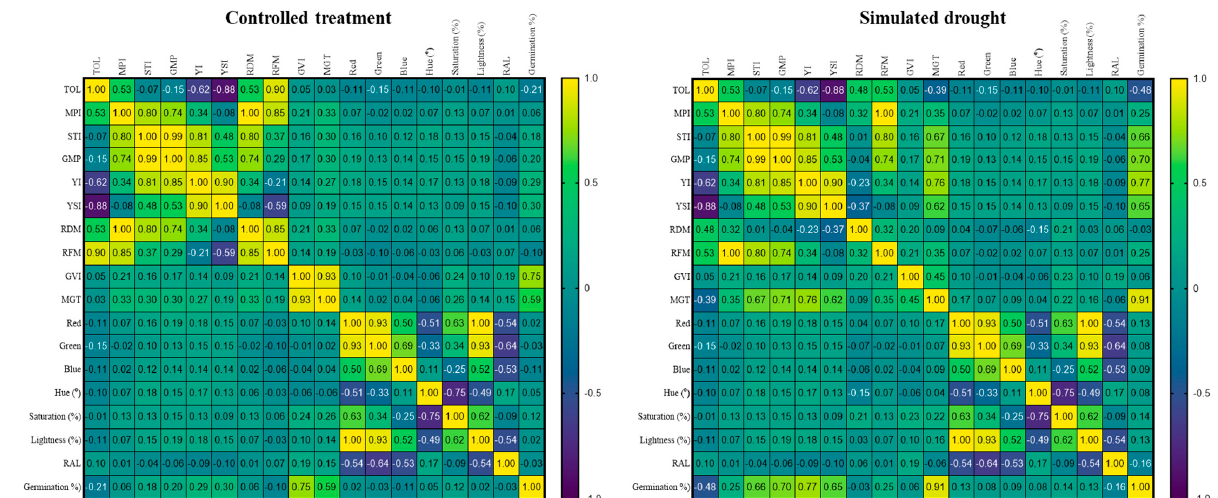
Figure 5. Correlations of drought indices, seed coat color, seed growth, and seed vigor based on the first two principal component axes (PC 1 and PC 2) for the 24 Bambara genotypes under controlled treatment and simulated drought conditions. SSI: stress susceptibility index, TOL: stress tolerance, MP: mean productivity, STI: stress tolerance index, GMP: geometric mean productivity, YI: yield index, YSI: yield stability index, RAL, Hue, Red: redness, Blue: blueness, Green: greenness., MGT: mean germination time, GVI: germination velocity index, RDM: roots dry mass, RFM, roots fresh mass. Under SD condition, significant and positive correlations were observed between MPI and STI ( r = 0.80), MPI and GMP ( r = 0.74), STI and GMP ( r = 0.99), STI and YI ( r =